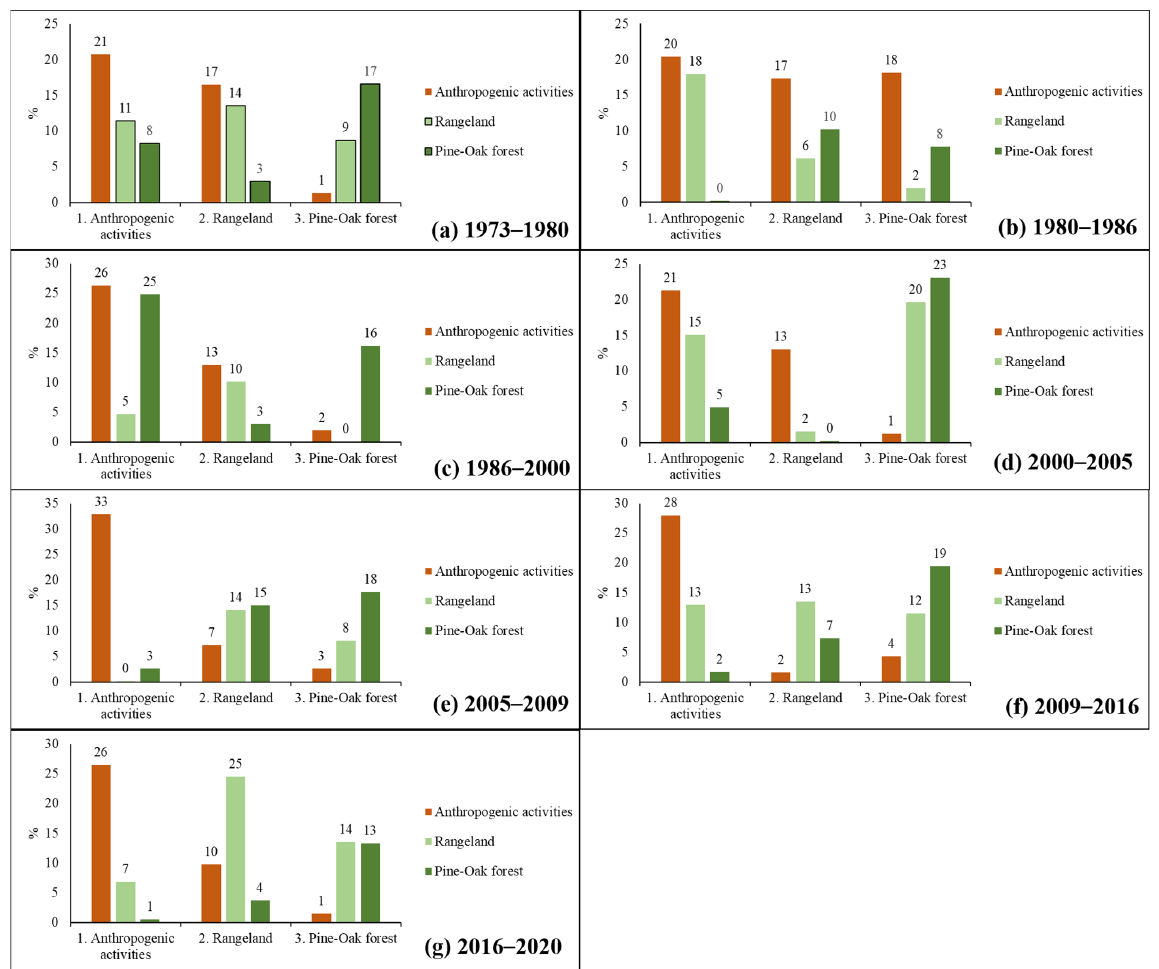
Figure 15. Land use coverage and changes in the study period, San Vicente, Palmillas, Tamaulipas, Mexico.